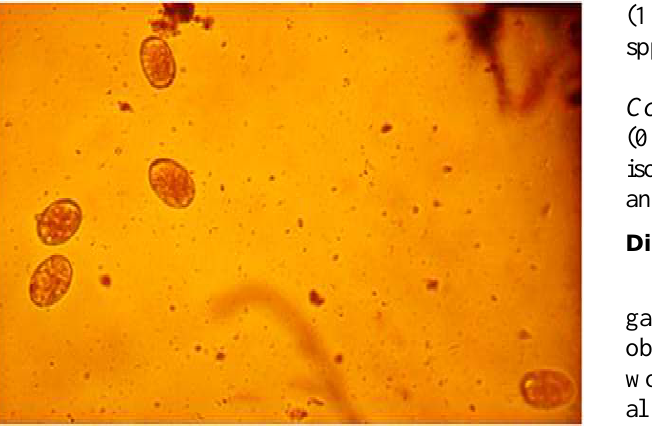
Figure-3. Photomicrograph of Strongyle eggs isolated from faecal sample of camel during the dry season in Sokoto metropolis (X10)